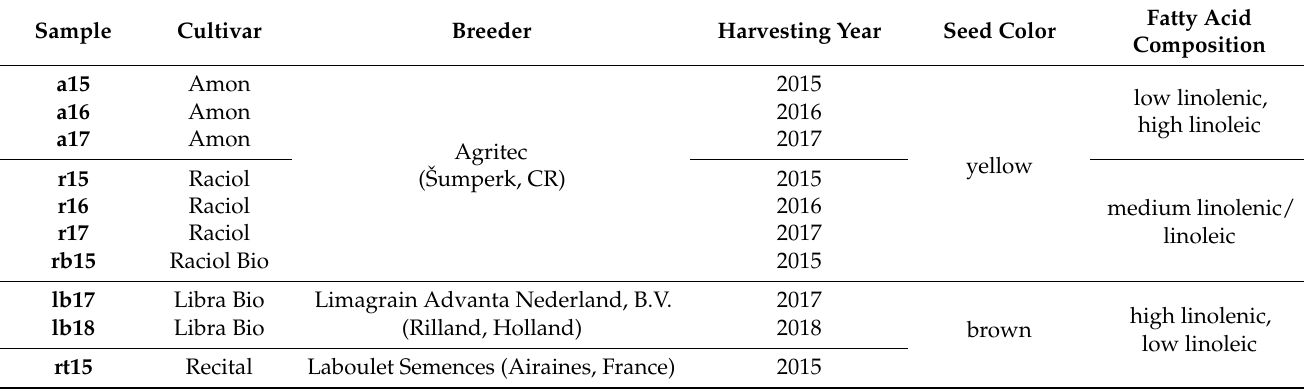
Table 1. Specification of flaxseed samples